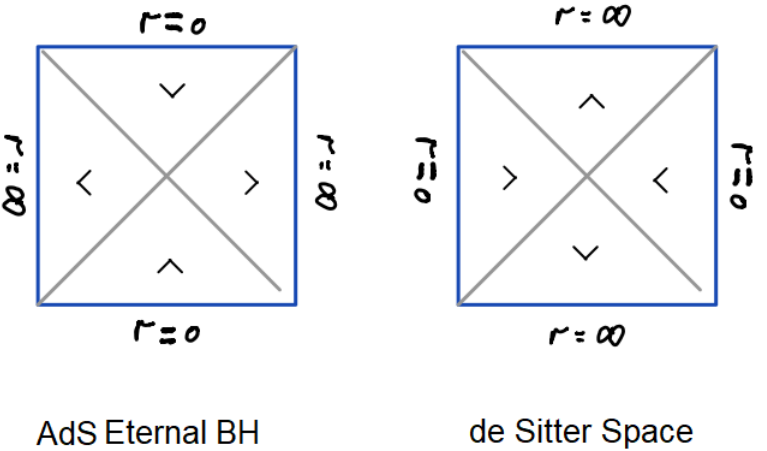
Figure 5. Penrose diagrams supplemented with Bousso wedges for the AdS eternal black hole and for de Sitter space.